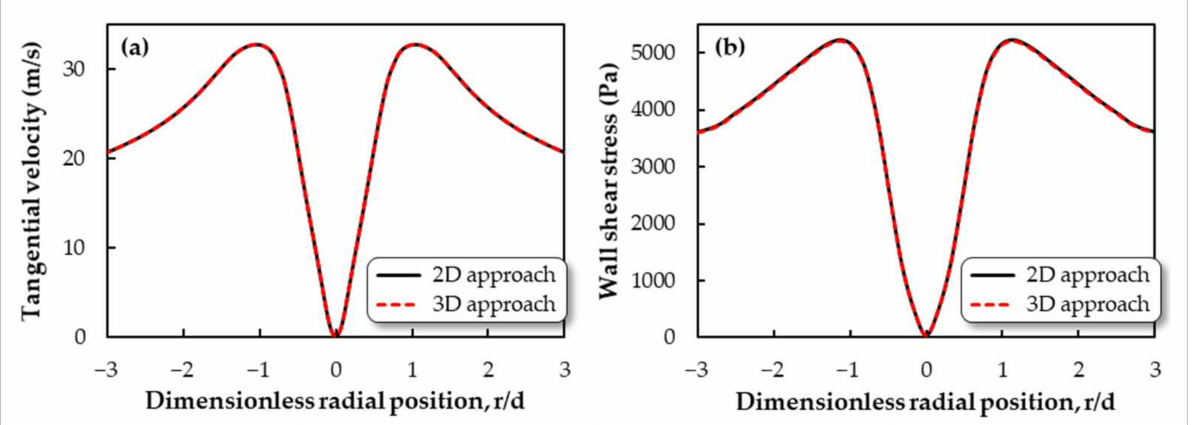
Figure 16. Comparison of 2D (solid black lines) and 3D (dashed red lines) approaches: ( a ) tangential velocity and ( b ) wall shear